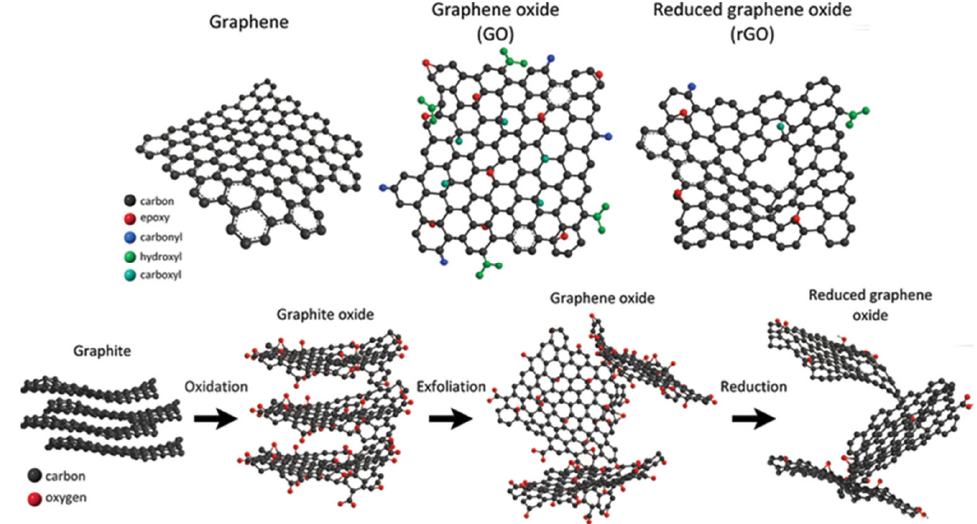
Figure 3. Methodologies for the production of graphene and related material structures through the oxidation of graphite. Reprinted from Jimenez-Cervantes et al. [28] under CC BY license.